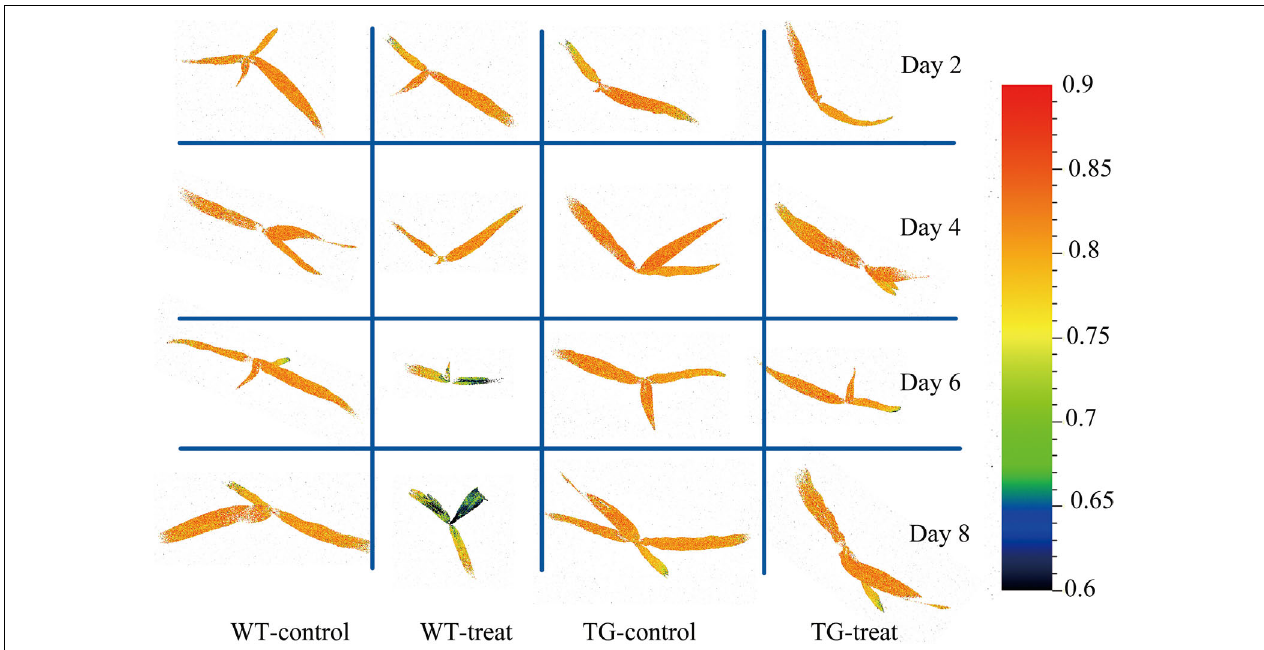
FIGURE 11 | Chlorophyll fluorescence images of maximum photochemical quantum yield of PSII ( F v /F m ) for the whole canopy of WT and TG maize during the time course study of response to glyphosate application. The color bar on the right side of the image represents the ranges of values and how they mapped to the color